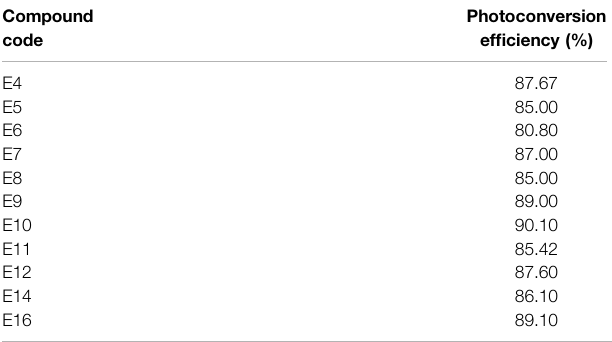
TABLE 2 | Photo conversion ef fi ciency of hockey-stick compounds during UV illumination. Compound code